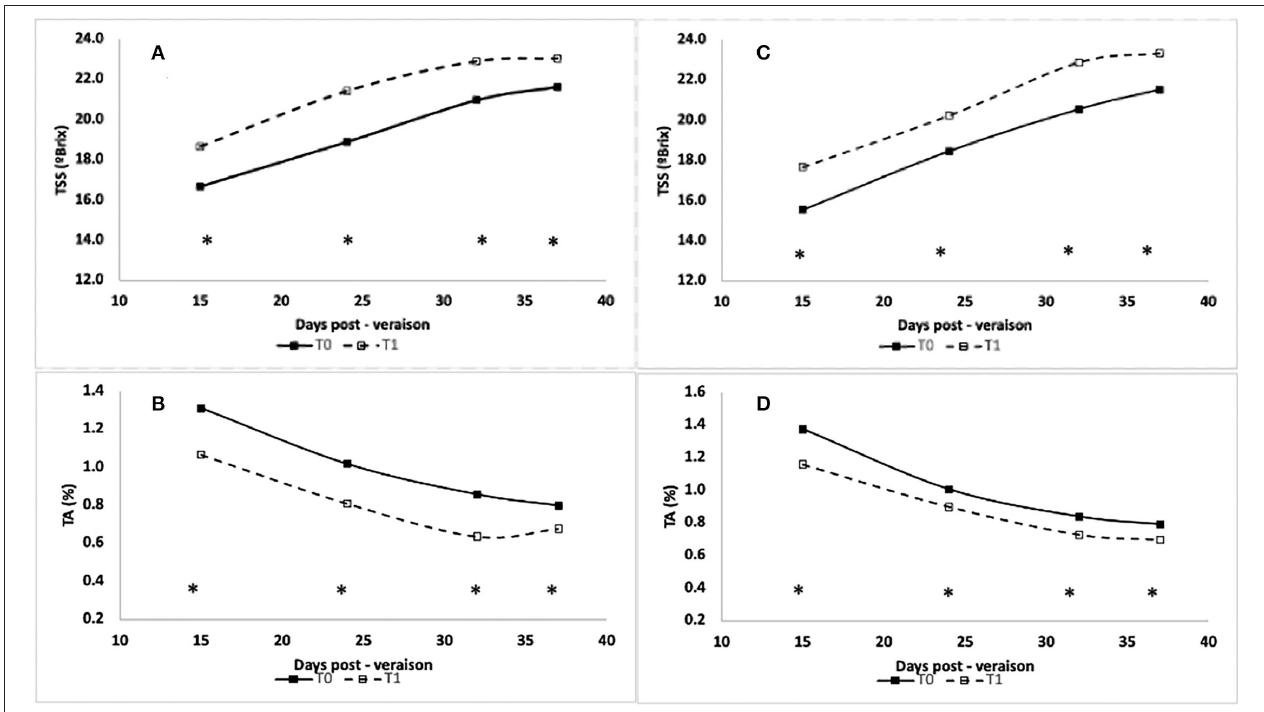
FIGURE 5 | Total soluble solids (TSS, ◦ Brix, A,C ) and Titratable Acidity (TA, %, B,D ) measured at different days post—veraison for CS ( A,B ) and Sy ( C,D ) cultivars during the 2018-2019 season (S1). Asterisk (*) represents significant differences ( p -value < 0.05).